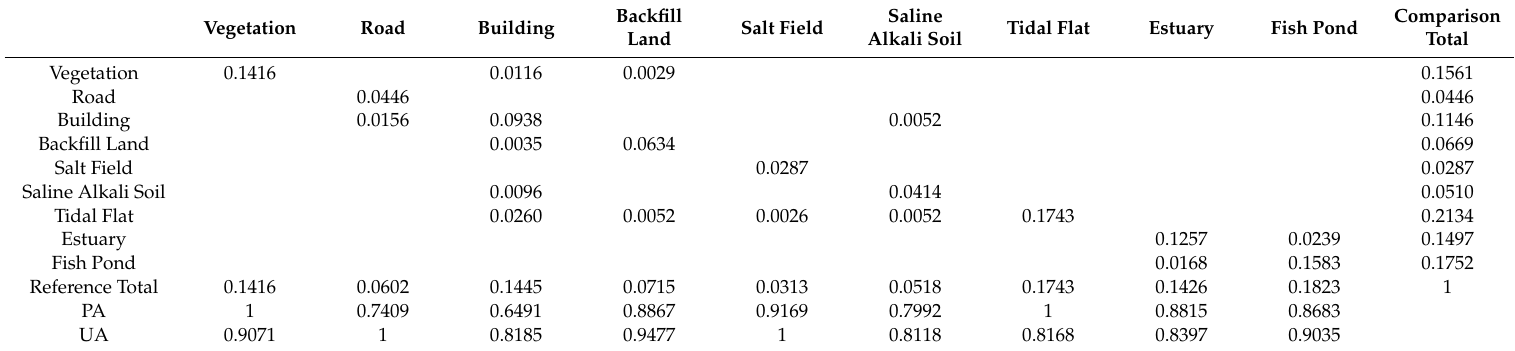
Table 8. Estimated population matrix of the SVM method in the WV-2 image.